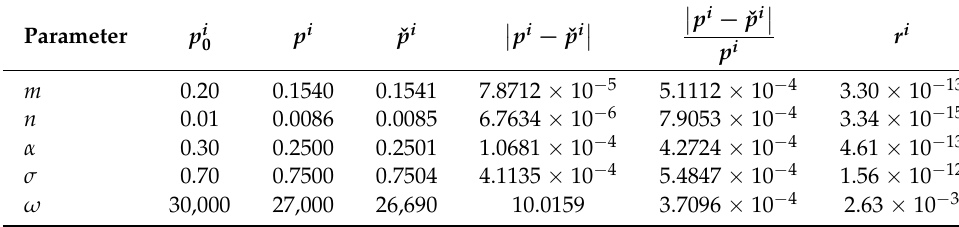
Table 4. Test with Caputo–Fabrizio model (4) with different values of r and q .